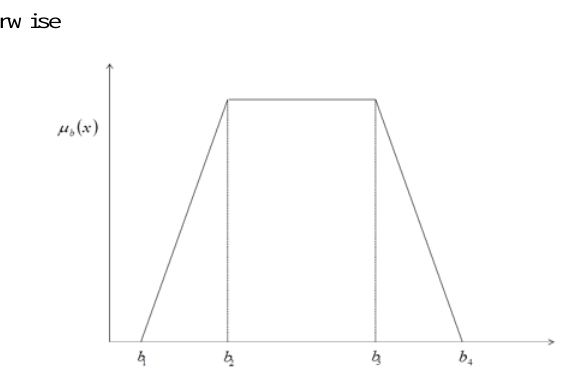
Fig. 1. Trapezoidal fuzzy